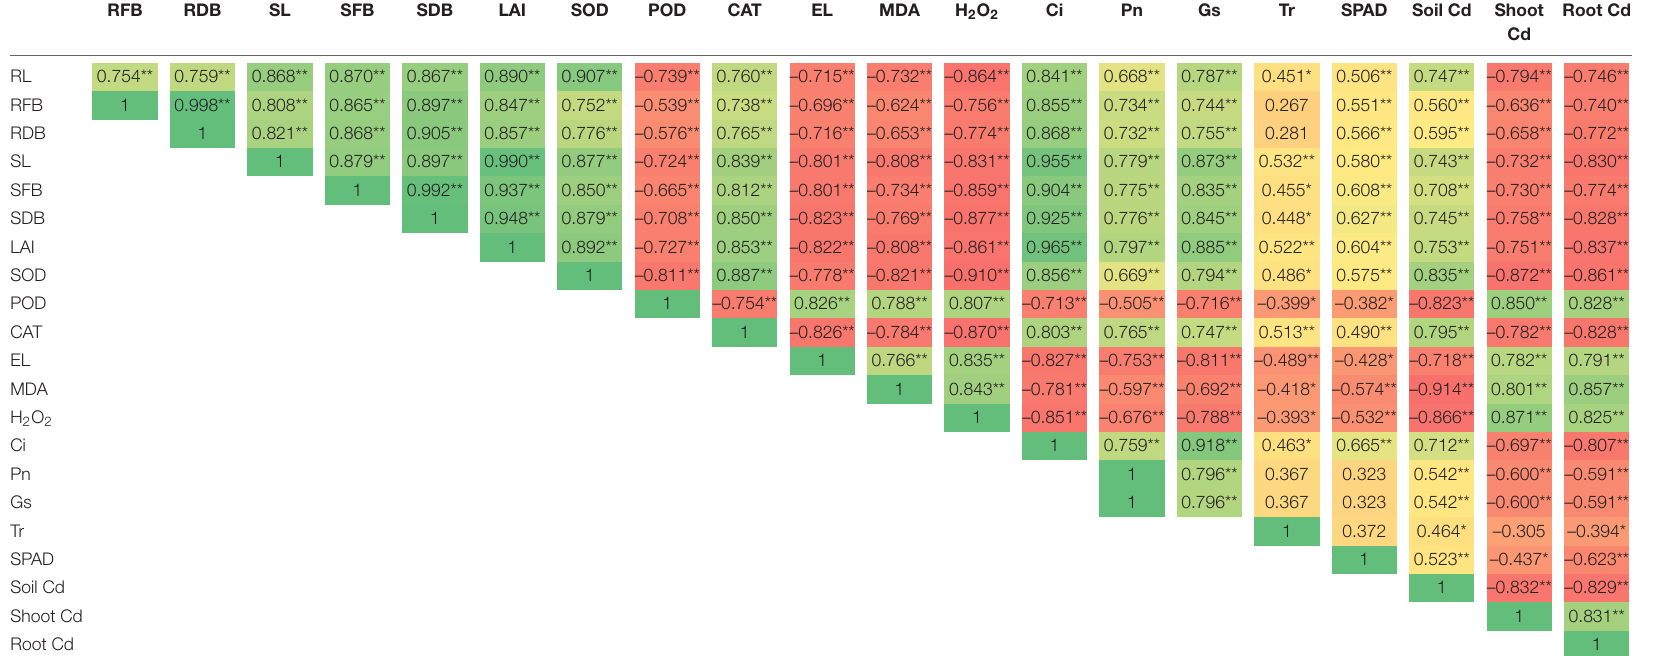
TABLE 2 | Pearson’s association between .various traits in maize ( n = 3) grown under Cd contamination